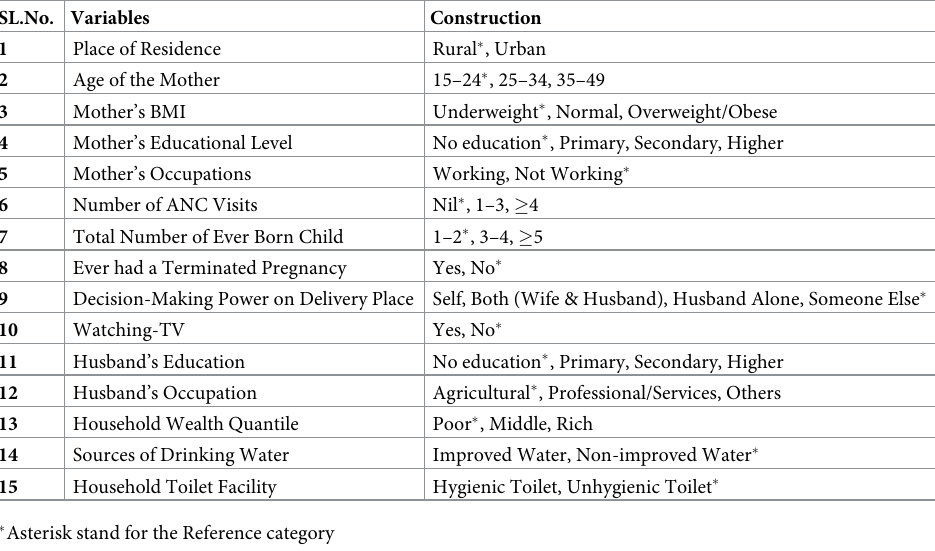
Table 1. Description of the